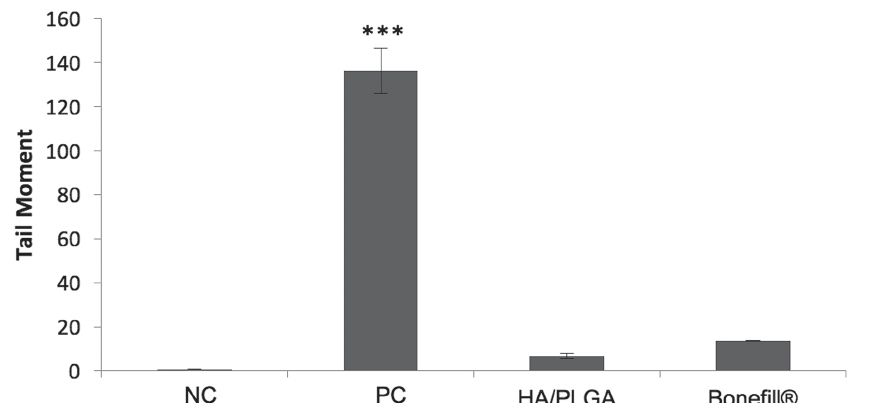
FIGURE 3 - Comet assay in CHO-K1. Cells treat with 100% concentration HA/PLGA and Bonefill ® eluates. NC: negative control; PC: positive control. Columns = mean of tail moment; bars = Standard error. *** = p<0.0001 compared to NC; Dunnett’s